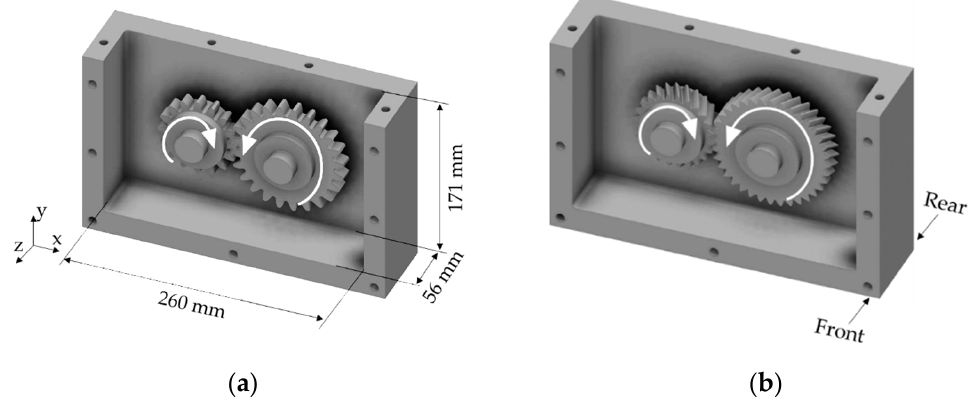
Figure 1. Considered test gearbox with gear-C ( a ) and gear-LL ( b ). Table 1. Geometry of the considered gear-C and gear-LL.